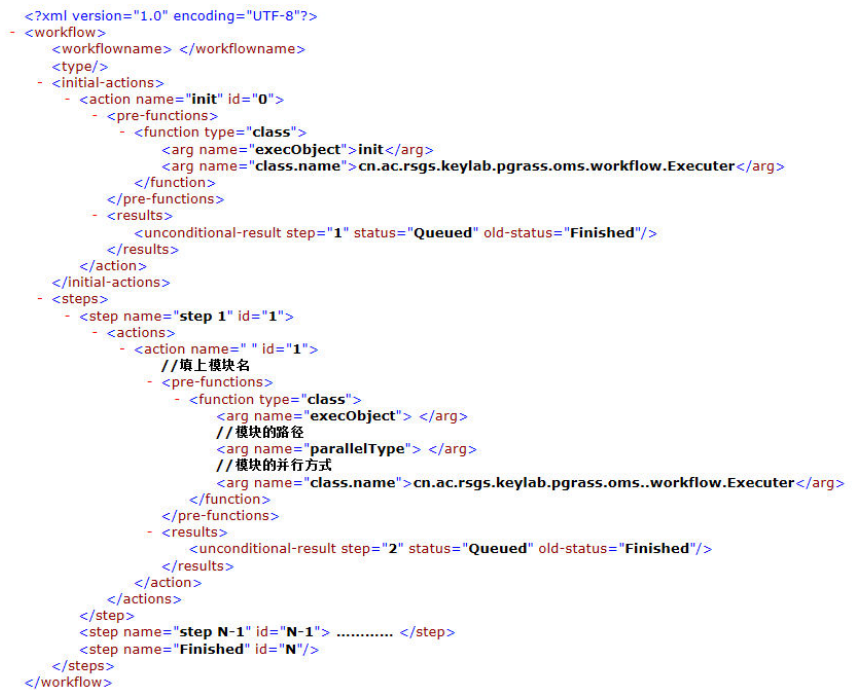
Figure 5. Workflow parameter